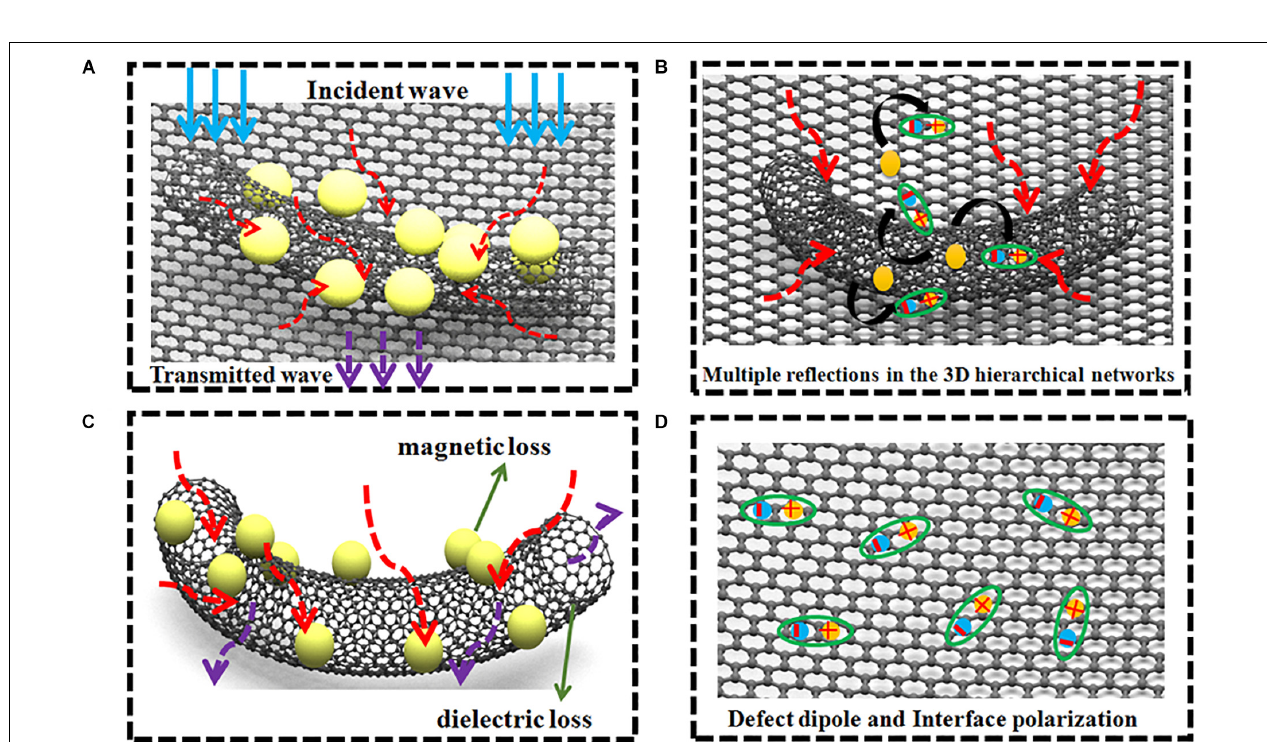
FIGURE 13 | Schematic illustration of possible EM wave absorption avenues of magnetic CNTs/GO NCs. (A,B) Multiple reflections, (C) dielectric and magnetic loss, and (D) defect dipole and interface